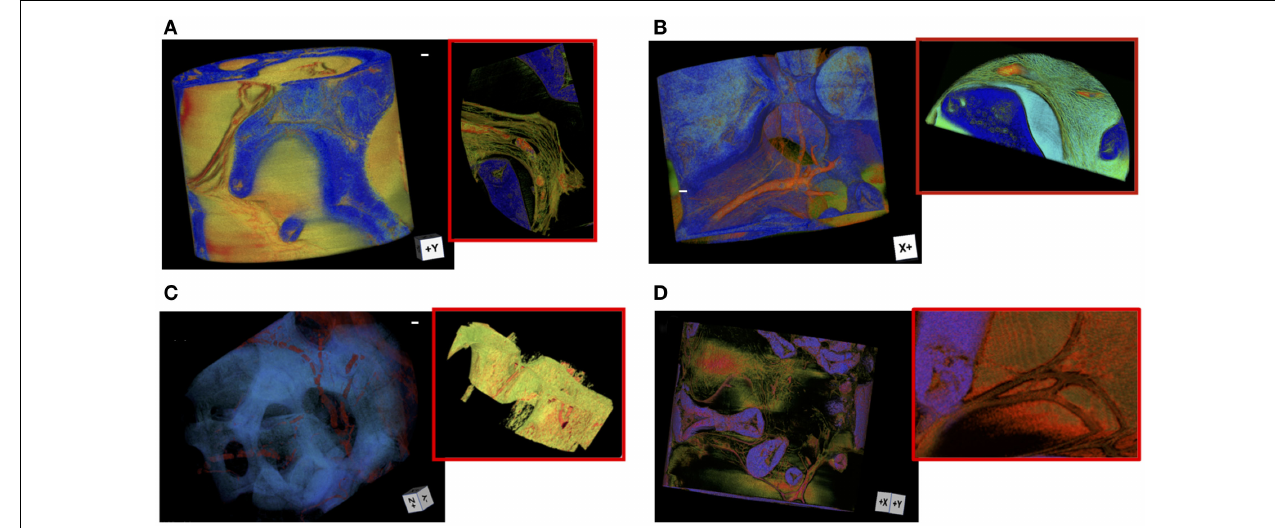
sample B was reported. The inset shows a very intricate collagen matrix (rendered in yellow) coexists with the vessels (light green). The newly formed bone is rendered in light blue. (C) The 3D volume of sample C is reported. The segmentation renders the vessels in red and the scaffold in blue. The soft tissues were computationally removed from the 3D rendering to highlight the vessels distribution inside the scaffold. The inset shows in red the numerous vessels crossing the soft tissue (segmented in green). (D) The sample D was BMSC seeded but not stained. The vessels are rendered in red, the soft tissue in yellow and green. The inset shows one of the ramified vessels in